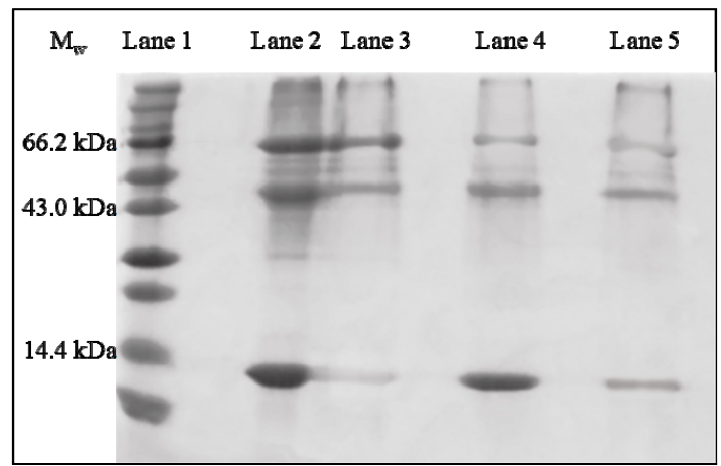
Figure 8. Sodium dodecyl sulfate polyacrylamide gel electrophoresis (SDS-PAGE) results of competitive adsorption experiment. Lane 1, protein molecular weight marker; Lane 2, solution of mixture of Bovine serum album (BSA), Ovalbumin (OVA), and Cyt c; Lane 3, the protein in the mixed solution after adsorption by MIMs; Lane 4, the protein eluted from MIMs; Lane 5, the protein eluted from NIMs.